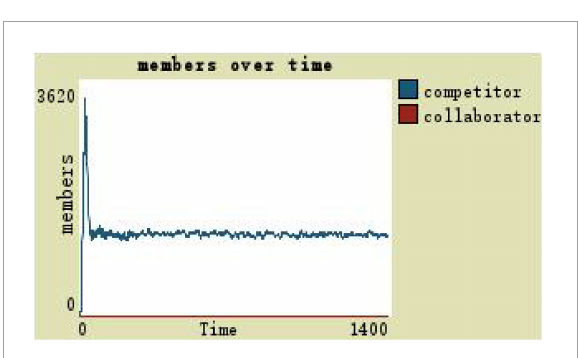
FIGURE7 Members change in low-trust team with the participatory leadership